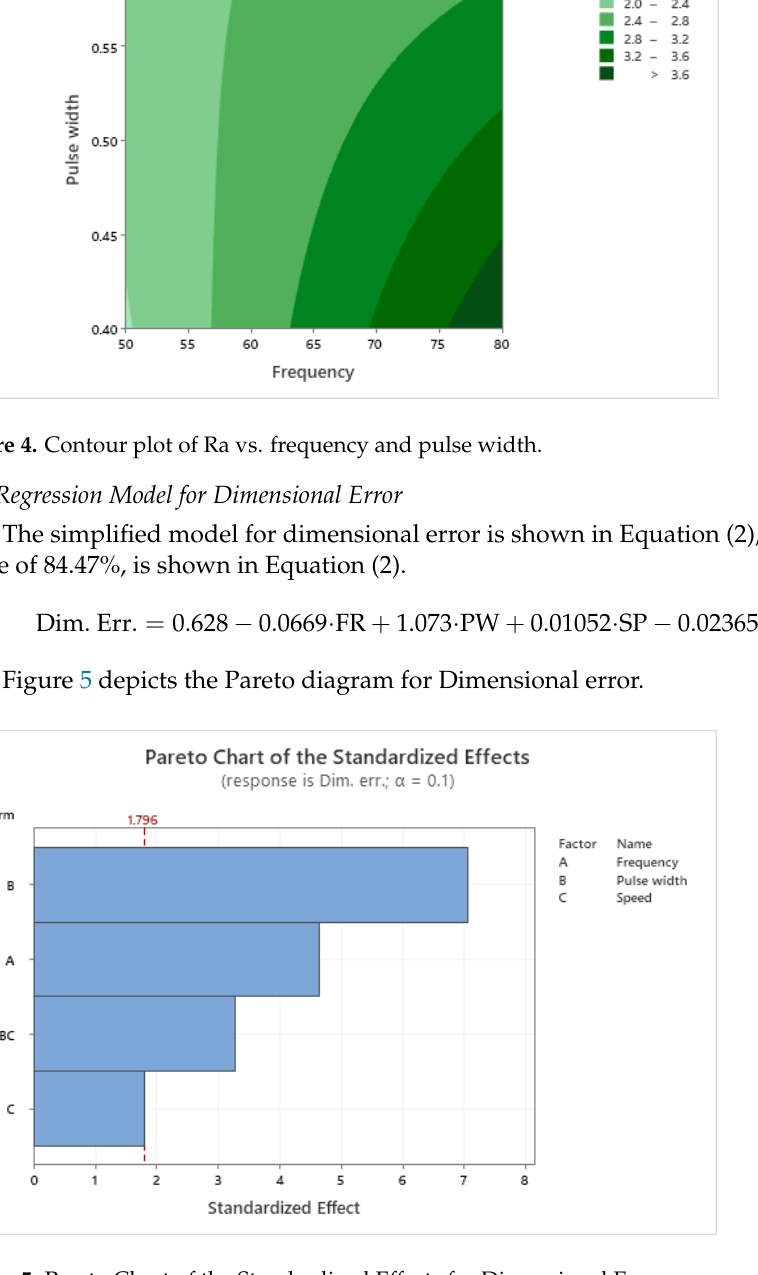
Figure 5. Pareto Chart of the Standardized Effects for Dimensional Error.